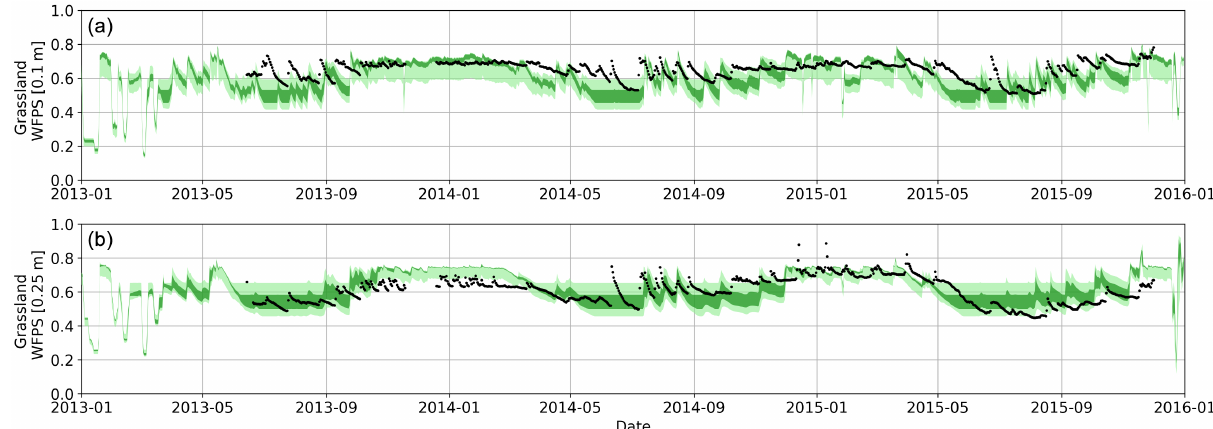
Figure A2. Modelled WFPS on grassland in different depths. RM- SEs ranging from 0.043 to 0.1481% WFPS (0.1m) and 0.056 0.1069% WFPS